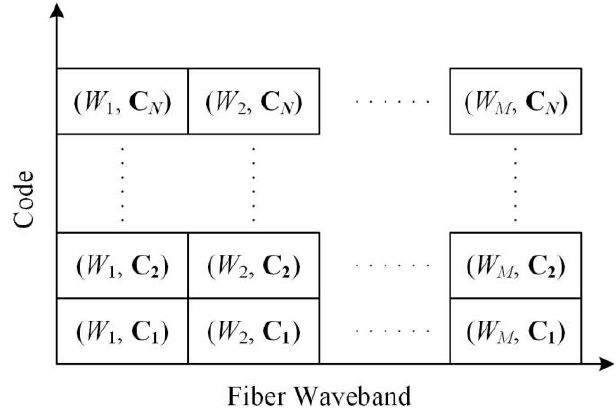
Figure 1. Classification of the wavelength-division multiplexing (WDM)/ optical code-division multiplexing (OCDM) labels.